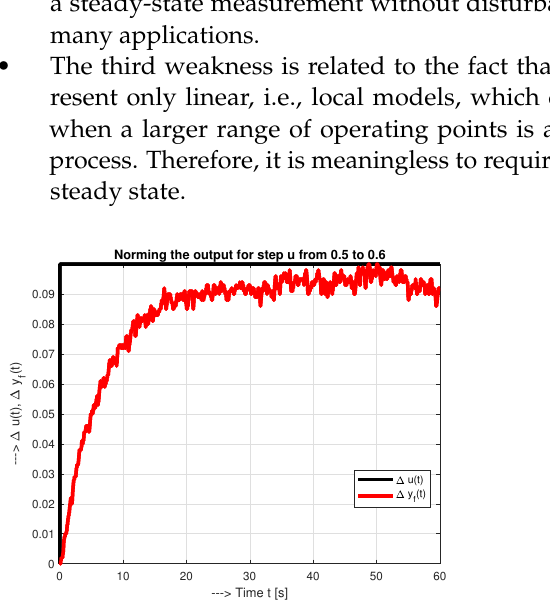
Figure 4. Norming one segment of the step response y f ( t ) corresponding to Figure 3 with the change of the input from u = 0.5 to u =